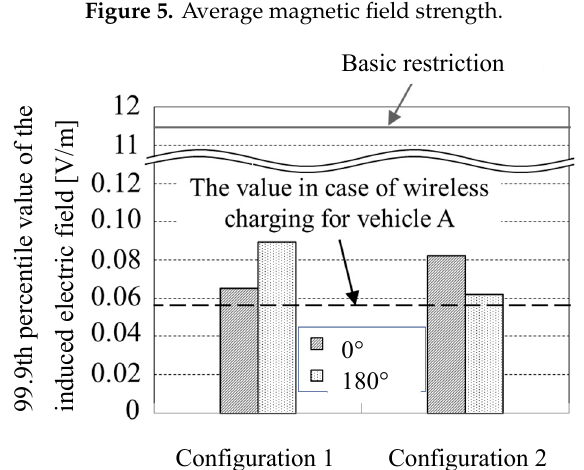
Figure 6. Induced electric field 99.9th percentile value of E in for the human model for each parking configuration.